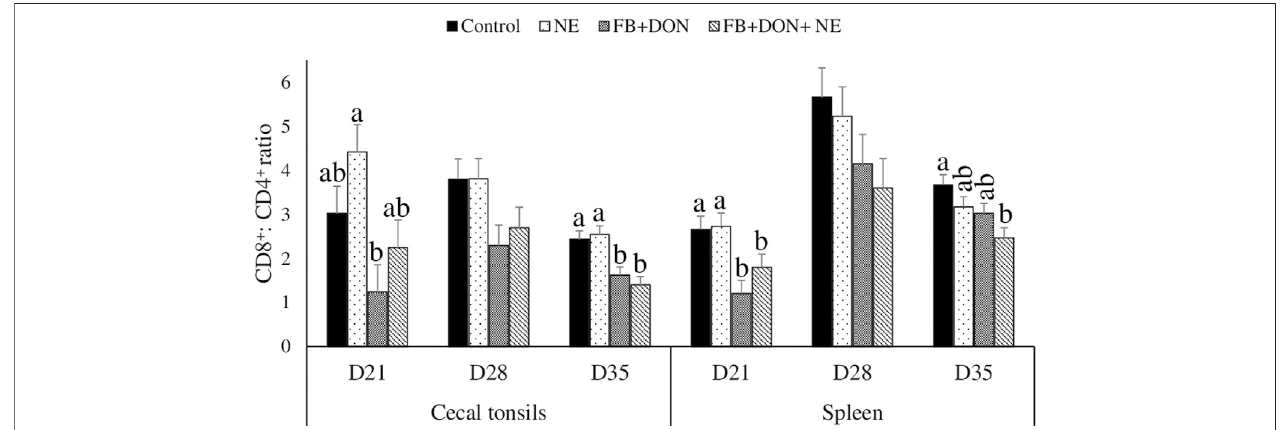
FIGURE 5 | Effect of subclinical dose of FB + DON and E. maxima/C. perfringens challenge on the spleen and cecal tonsil CD8 + : CD4 + ratio. Day-old chicks were distributedintofourtreatmentgroups:control,necroticenteritis(NE),fumonisin+deoxynivalenol(FB+DON),andFB+DON+NEgroups.BirdsintheNEandFB+DON + NE groups received 2.5 × 10 3 Eimeria maxima oocystper bird on day 14. All birds received 1 × 10 8 CFU/bird of Clostridium perfringens on days 19, 20, and 21. CD4 + and CD8 + cells were identi fi ed using fl uorescent-linked anti-chicken CD4 and CD8 in a fl ow cytometer. Bars (+SEM) without a common superscript differ signi fi cantly ( p < 0.05). n = 8 (8 pens of 15